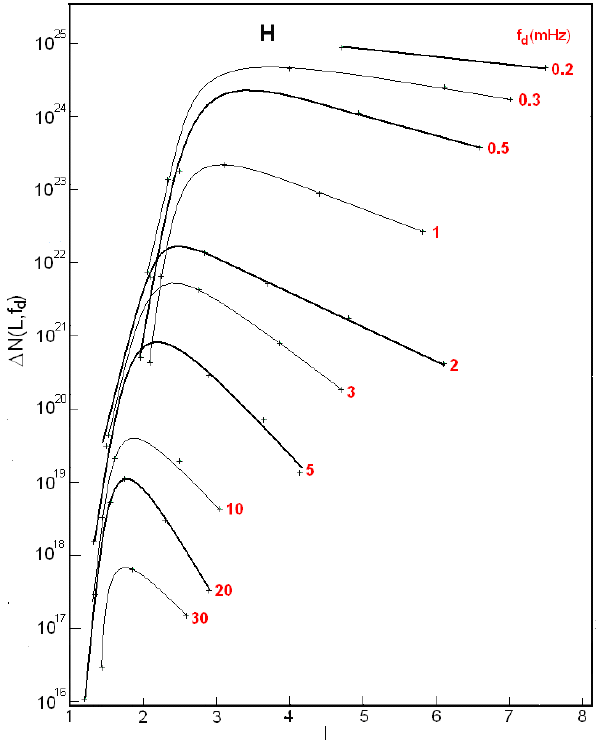
Figure 4. Radial profiles (cid:49)N(L,f d ) for protons of the ERB with drift frequencies f d = 0 . 2, 0.3, 0.5, 1, 2, 3, 5, 10, 20, and 30mHz, plotted for periods of maximum solar activity. The f d values cor- responding to each curve are highlighted in red. For clarity, thin curves are interspersed with thick